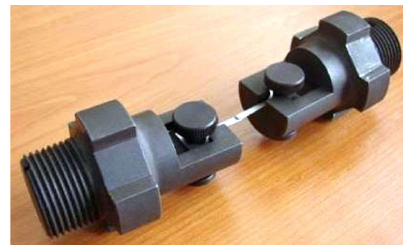
Figure 5. Specimen fixing assembly.